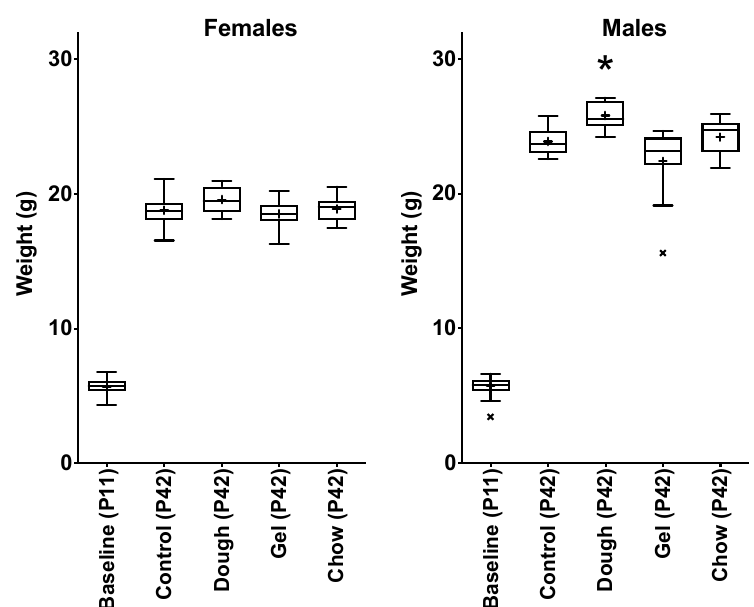
Figure 2. Weight distribution at baseline and endpoint by sex. At baseline, the cohorts were normally distributed. Two weeks after the withdrawal of supplement, weights were normally distributed except for the Gel-supplemented male cohort ( p = 0.0476) and the average weights of males that were supplemented with Dough were significantly higher than controls ( p = 0.0016), indicated with an asterisk. Animals 2020 , 10 , x